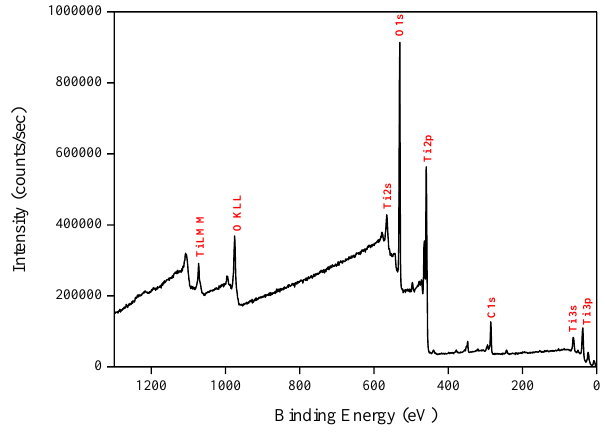
◦ Figure 9. Typical XPS survey of TiO 2 films deposited by ALD at 200 °C. Figure 9. Typical XPS survey of TiO Figure 9. Typical XPS survey of TiO 2 films deposited by ALD at 200 °C. 2 films deposited by ALD at 200